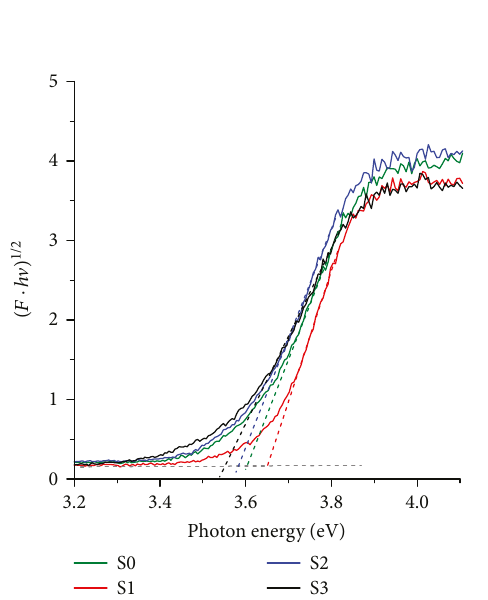
Figure 3: Transformed di ff use re fl ectance spectra of the initial (S0) and protonated (S1, S2, and S3) Rb